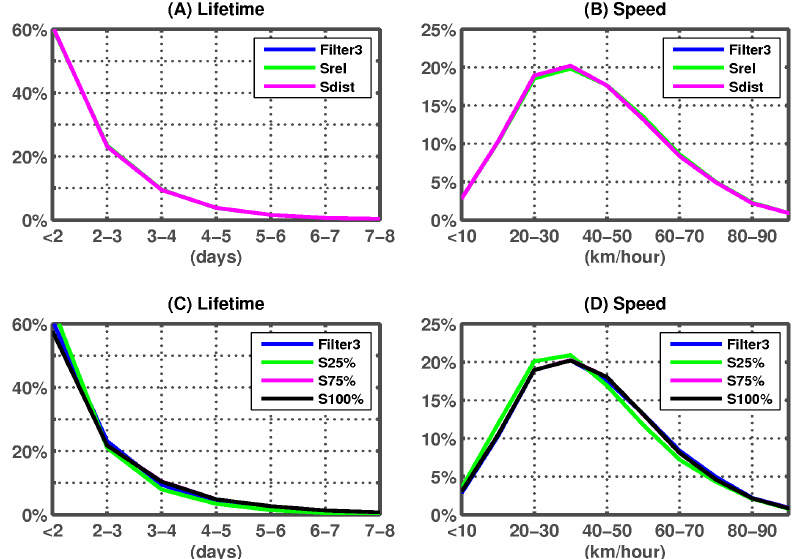
Figure 10. (a) Relative frequency distribution of cyclones’ lifetime for the sensitivity tests filter3, S rel and S dist . (b) As in (a) but for cyclones average speed. (c) As in (a) but for the sensitivity tests filter3, S 25 % , S 75 % and S 100 % . (d) As in (b) but for the sensitivity tests filter3, S 25 % , S 75 % and S 100 %